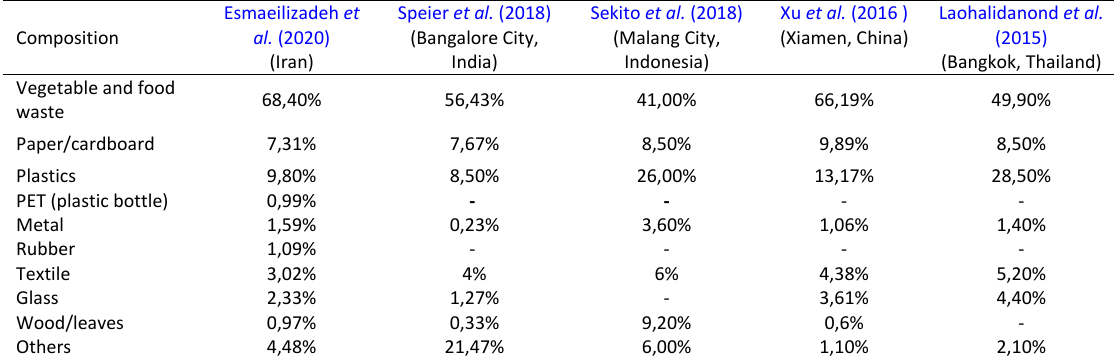
Table 1: MSW compositional characteristics from various cities in developing countries